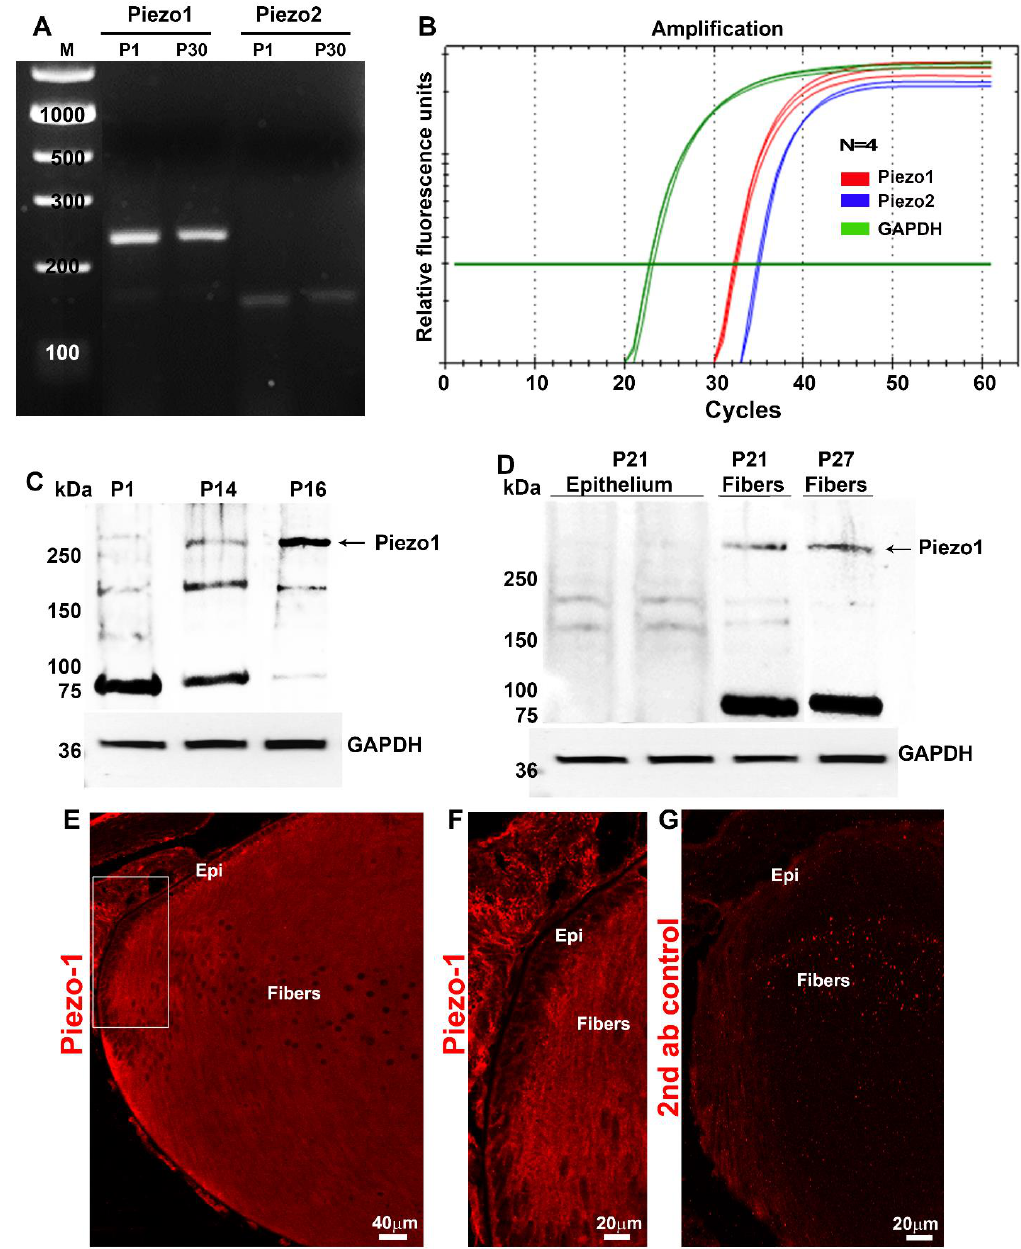
Figure 3. Expression and distribution of Piezo channels in mouse lenses. ( A ). RT-PCR-based confir- mation of Piezo1 and Piezo2 expression in P1 and P30 mouse lenses. ( B ). qRT-PCR analysis revealed a relatively much higher level of Piezo1 expression in the lens (P30) compared to Piezo2. ( C ). Total lysates (800 × g supernatants; 75 µ g protein) derived from the P1, P14, and P16 mouse lenses analyzed using a Piezo1 polyclonal antibody exhibited immunopositive bands with an expected molecular mass of >250 kDa and >150 kDa. There was also a prominent immunopositive band at >75 kDa in the P1 and P14 lenses, the levels of which appeared to be decreased in the P16 lenses. ( D ). Piezo1 immunopositive bands of >250 and >75 kDa were present predominantly in the lens fiber samples (P21 and P27) compared to the lens epithelium (P21). ( E , F ). Immunofluorescence analysis of Piezo1 in the P1 mouse lens (the sagittal plane of the cryosection) revealed that the protein distributes predominantly to lens fibers relative to the epithelium (boxed area in panel ( E ) was magnified and shown in panel ( F )). ( G ) Shows background immunofluorescence with secondary antibody alone. GAPDH: Loading control; Epi: Epithelium; Bars: Image